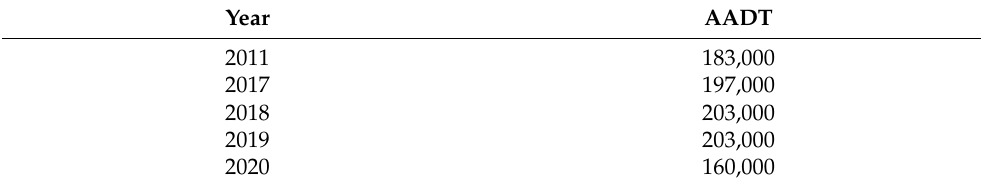
Table 2. Project Center in Saint Paul Annual Average Daily Traffic